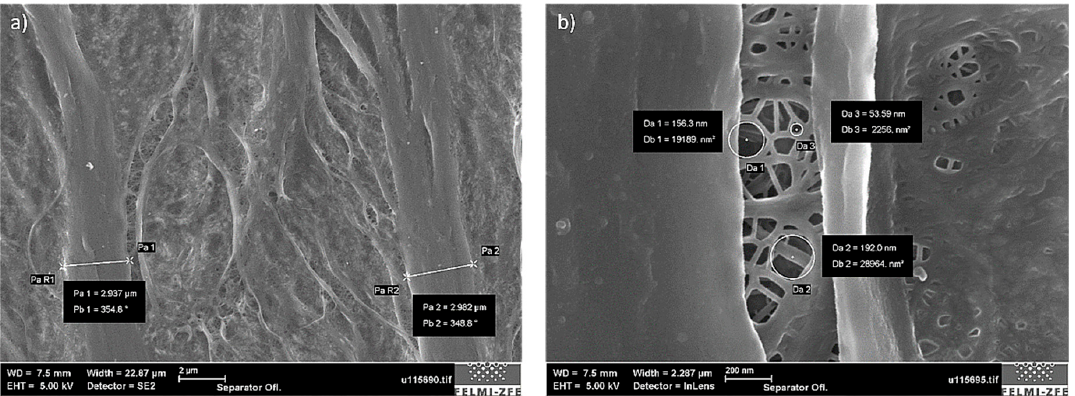
Figure 12. Separator fiber thickness and pore size determination: ( a ) shows the thickness of the largest fibers with diameters of about 3 µm, ( b ) reveals a pore size of about 50 nm.